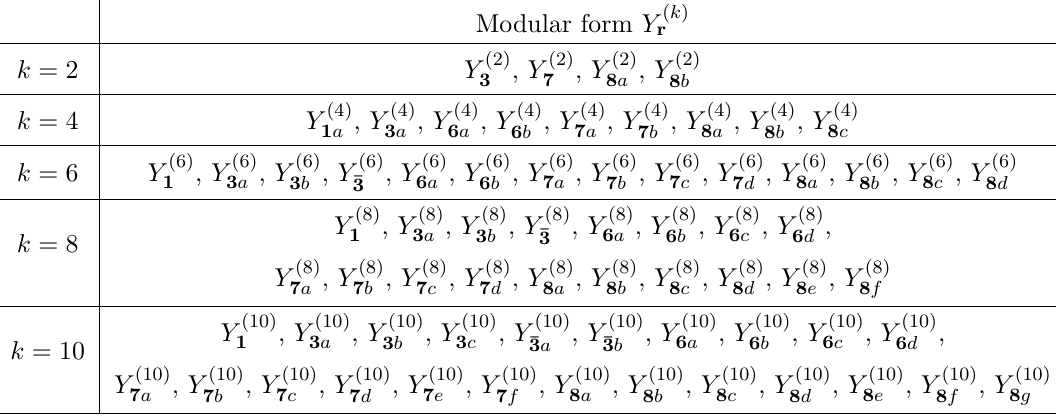
Table 1 . Summary of modular forms of level 7 up to weight 8, the subscript r denotes the transformation property under (cid:0) 7 modular symmetry. Here Y (2) 2 modular forms transforming in the representation 8 of (cid:0) 7 . The same convention is adopted for other modular